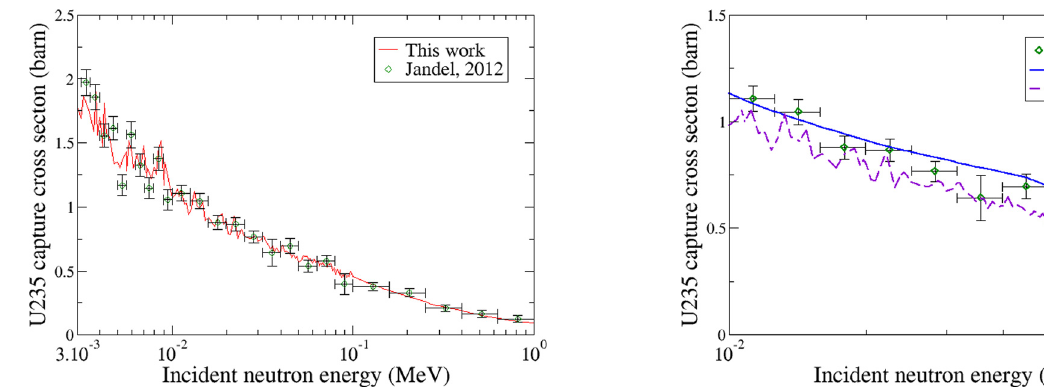
Fig. 7. Results of differential measurements from Jandel et al. [16] for 235 U capture from 3keV to 1MeV. Comparison with assimilation results applied to JEFF-3.1.1 point-wise evaluations (red continuous line).